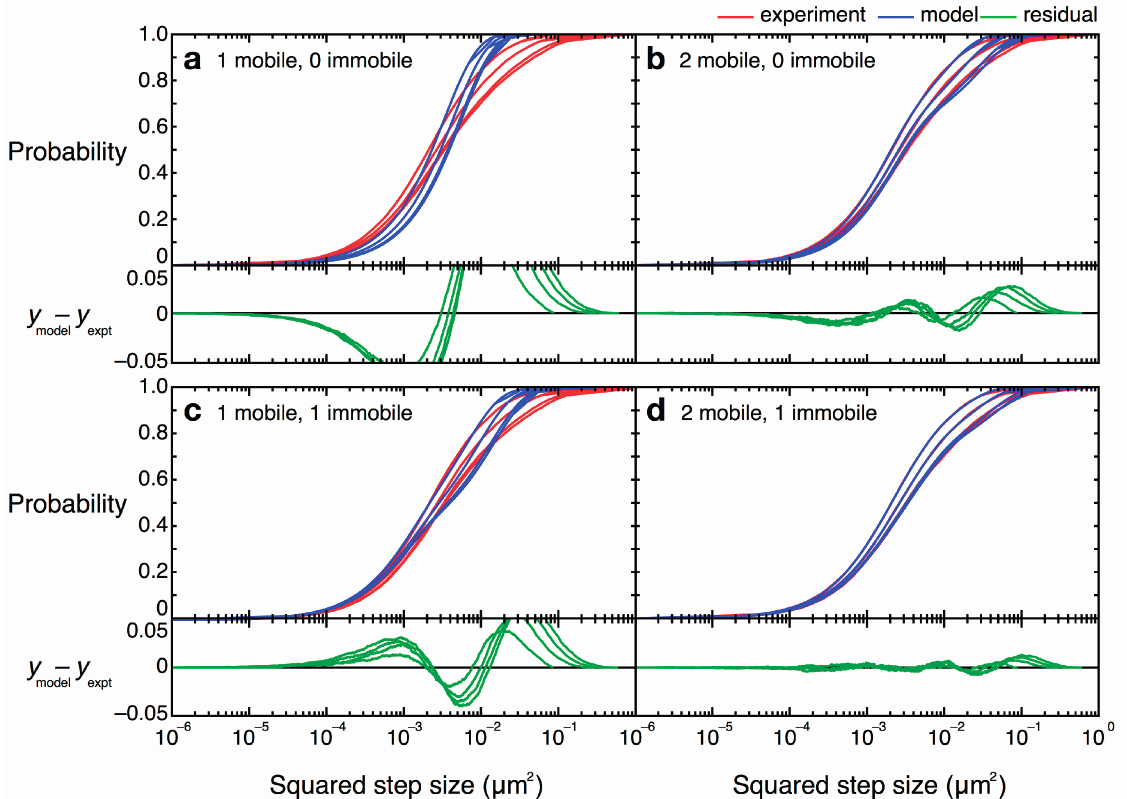
Figure 12. CPD curves and alternative models for TcpP-PAmCherry diffusion. blue. Curves for the first four time lags (50–200 ms) are plotted left to right. Residuals are shown in green. ( a – c ) Models with fewer than three terms did not describe the data well; ( d ) A model with two mobile terms and one immobile term described the CPD data